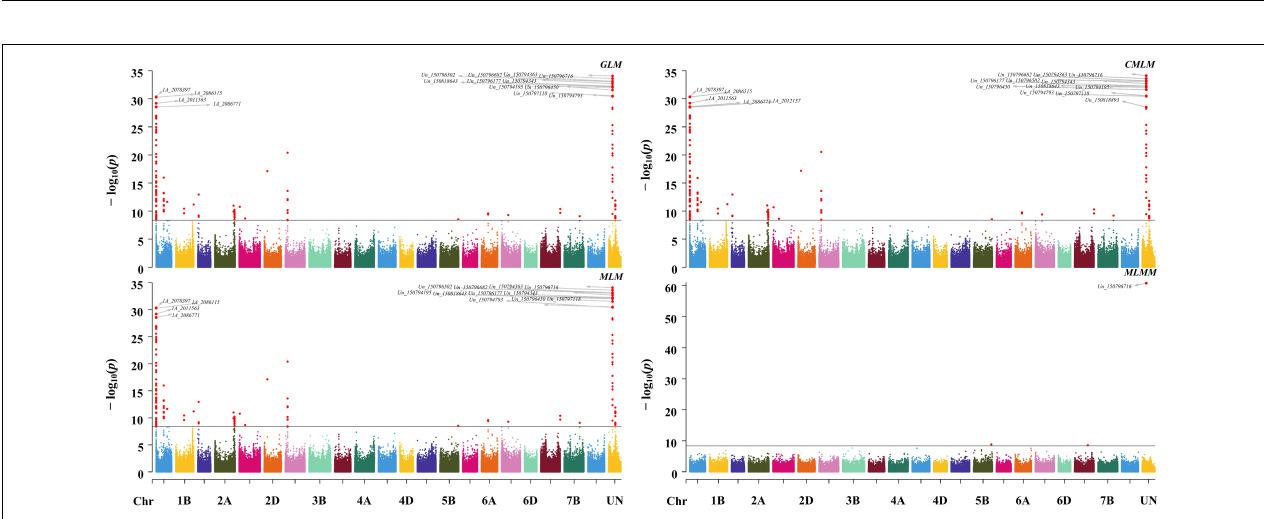
FIGURE 2 | Manhattan plots of GWAS for Gp using GLM, MLM, CMLM, and MLMM methods. The associated SNPs with p -value ≤ 1 × 10 – 28 were tagged on the plots.